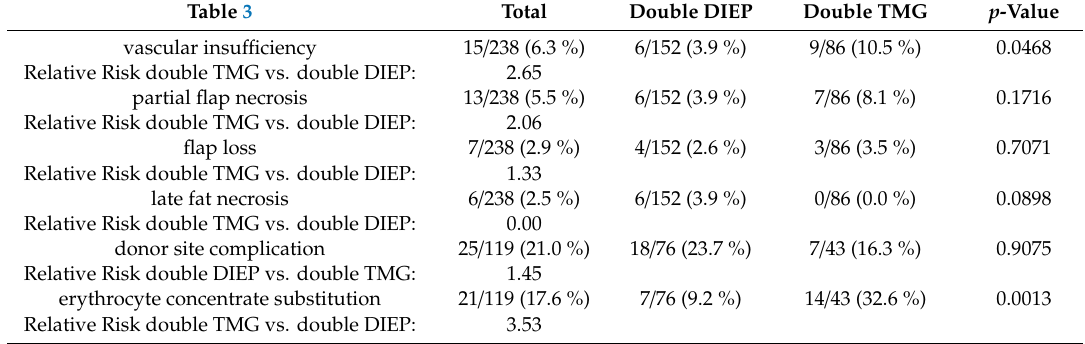
Table 3. Comparison of complications and Relative Risk calculation.